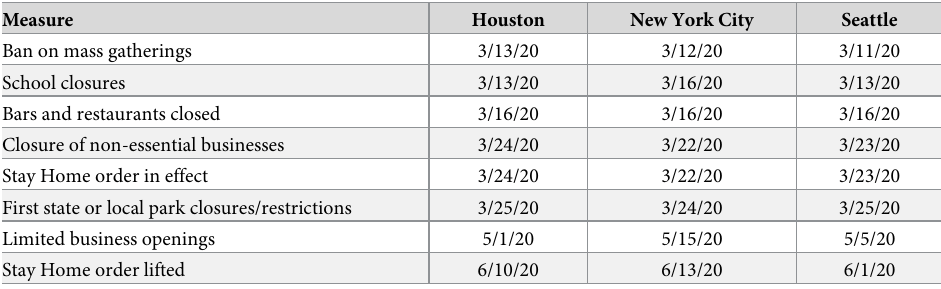
Table 1. List of restrictive public health measures by